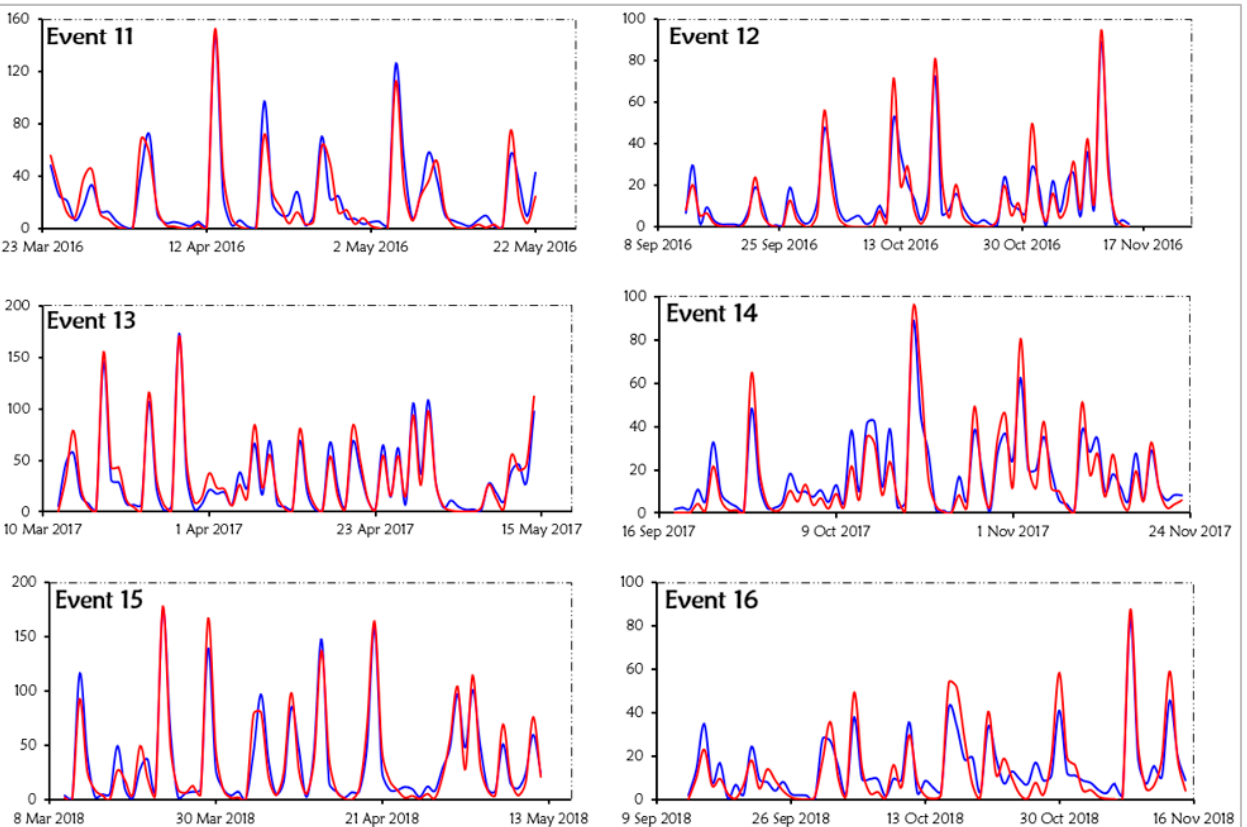
Figure 8. Simulated and observed flow hydrographs for the events (validation).